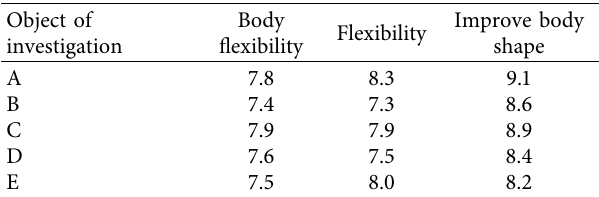
Table 2: Benefits of learning